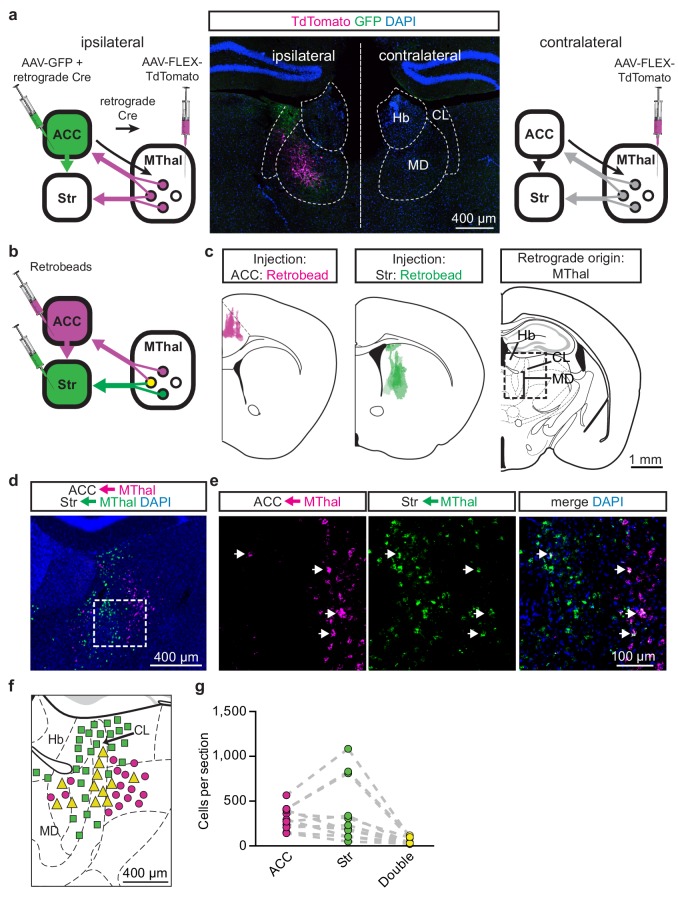
A subset of mediodorsal thalamic neurons send collaterals to both the ACC and DMS.(a) Experimental diagram in which AAV-FLEX-TdTomato was injected bilaterally into the MThal (left and right panels) and an example image of the labeling (middle panel). A combination of AAV-GFP and rAAV-retro-Cre (retrograde Cre) was injected into the ACC (ipsilateral, left panel). DAPI-stained (blue) coronal brain slice with retrograde labeled thalamic neurons expressing TdTomato (red, amplified with anti-DsRed primary and Alexa 594 secondary antibodies) and GFP-positive axons (green, amplified with anti-GFP primary and Alexa 488 secondary antibodies) originating from the ACC (middle panel). (b) Experimental diagram of fluorescent retrograde bead (retrobead) injections into the ACC and the striatum. (c) Averaged retrobead injection sites are shown in relationship to the mouse brain atlas (left panel, magenta, and center panel, green) as described in (b). The region of interest in which fluorescent retrobeads were imaged and counted in the MThal is shown as the squared box on an mouse brain atlas section (right panel). (d) Example image of retrobeads in the Mthal in ACC- (magenta) and Str-projecting (green) neurons from the area outlined in (c). (e) High magnification images of retrobeads in the MThal from the box outlined in (d). Arrowheads: neurons doubled labeled with both retrobeads (green and magenta). (f) Locations of retrograde labeled neurons surrounding the MThal were mapped onto the mouse brain atlas with estimation. Magenta circles: striatum-projecting neurons; green squares: ACC-projecting neurons; yellow triangles: striatum-projecting and ACC-projecting neurons. Note that the size of the markers is not to scale. (g) Summary graph showing the number of ACC (magenta), Str (green), or double labeled (yellow) retrobead clusters quantified per slice. Hb: habenula; CL: central lateral thalamus; MD: mediodorsal thalamus.